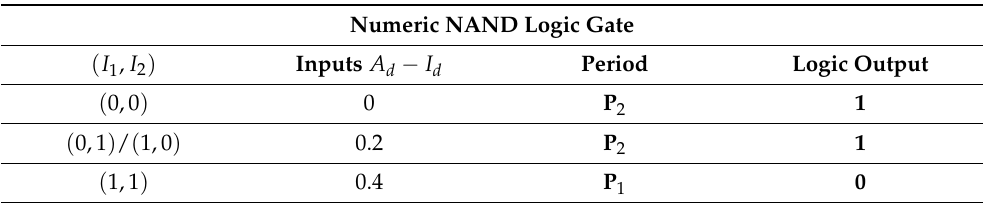
Figure 9. EDFL response to a modulation signal ( a ) without bias, ( b ) with a bias of 0.4 V. The addition of a positive bias increases the amplitude of the peak and decreases the amplitude of the valley, with respect to zero. It also shortens the time the signal is in a negative state and lengthens the time with a positive value. Table 2. NAND logic gate constructed from the numerical laser response defining P 2 as logic 1 and P 1 as logic 0. The modulation frequency is fixed at 44 kHz.